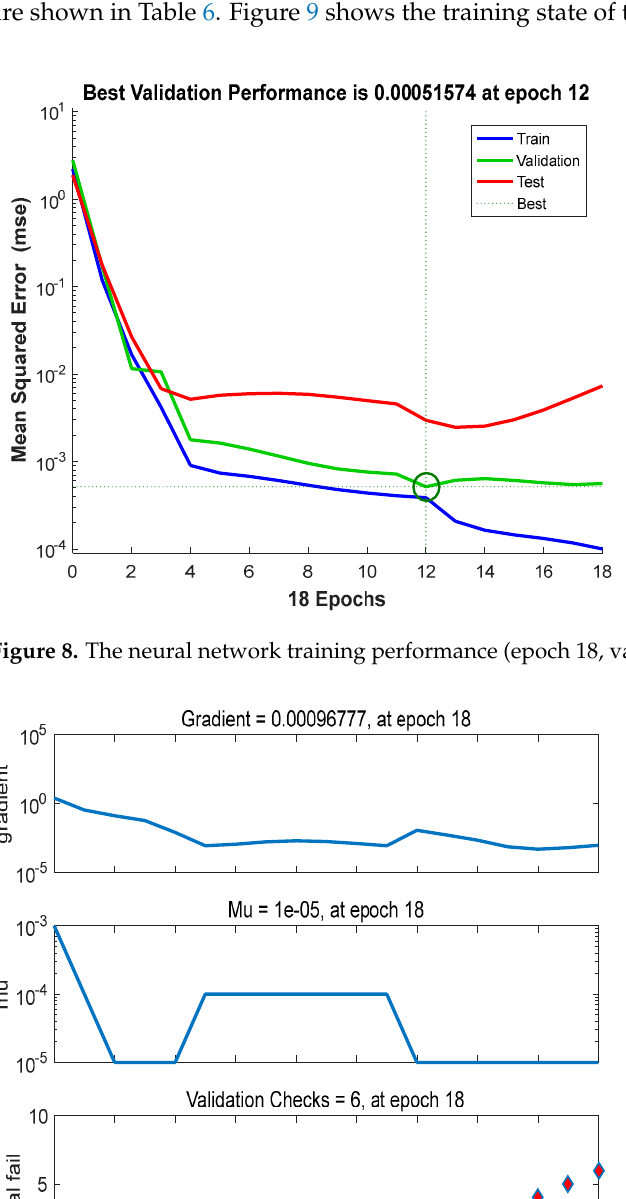
Figure 8. The neural network training performance (epoch 18, validation stop) . Table 6. Optimum ANN parameters for the design of the model Sr.No.